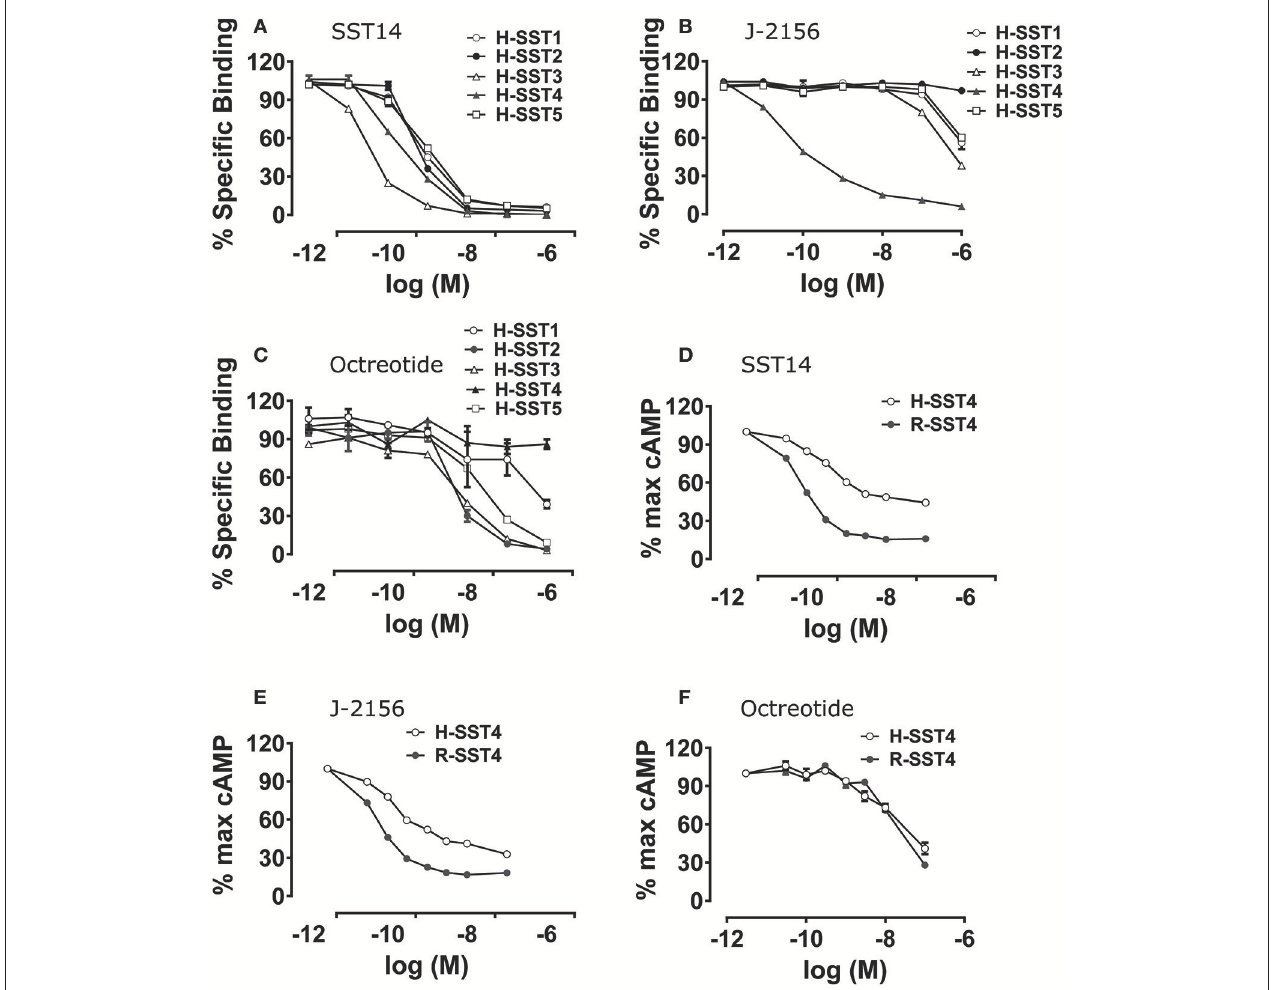
FIGURE 1 | Binding affinity and potency of J-2156 at the five somatostatin receptor types. Panels in the figure show (A) binding curves of the endogenous somatostatin receptor ligand- somatostatin 14; no selectivity was observed, (B) binding curves of J-2156; more than ∼ 300-fold selectivity for the SST4 receptor was observed relative to that for the other somatostatin receptor types, (C) binding curves of octreotide; low affinity was seen at SST4 receptor. Competition binding assays were run using 125 I radiolabelled somatostatin 14 (0.05nM) in the presence of 0.5 µ g protein. (D,E) present the concentration response curves showing that SST14 and J-2156 inhibited forskolin (30 µ M and 10 µ M for rat and human SST4 receptor, respectively)-stimulated cAMP production in H4 cells expressing the rat and the human SST4 receptor types. Similarly, (F) shows that octreotide, the negative control, was unable to inhibit cAMP production in both human and rat SST4 receptor. H-SST1-5, human somatostatin receptor types 1-5; R-SST4, rat somatostatin receptor type 4.